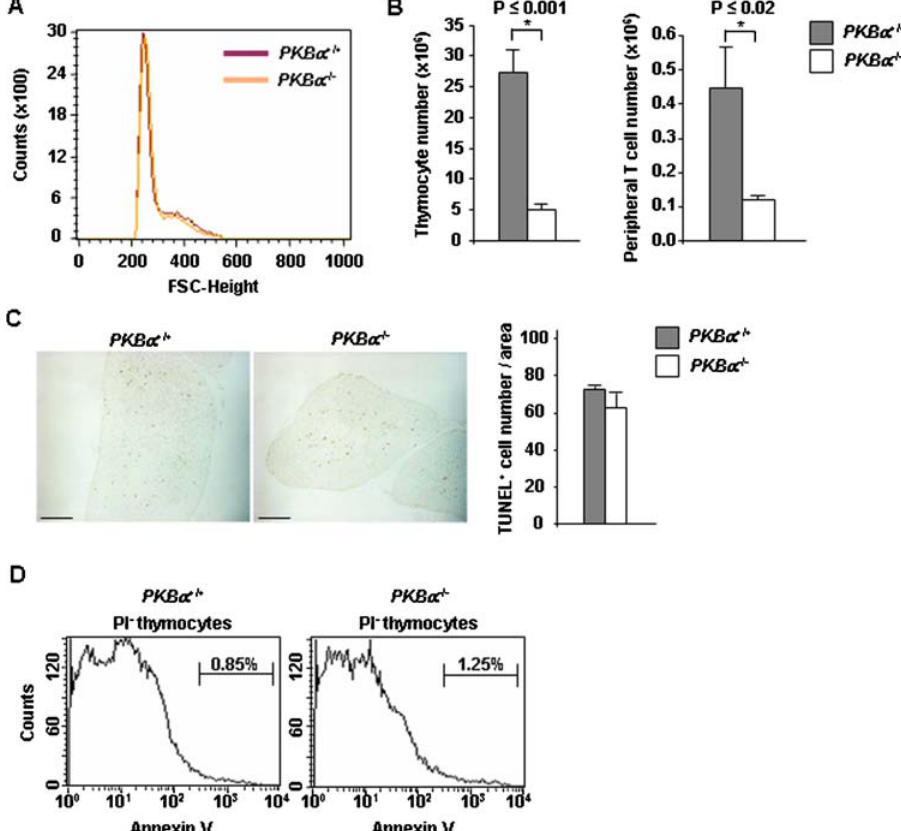
Figure 2. The deletion of PKB a leads to a reduced number of thymocytes in neonatal mice. A: Thymocytes were isolated from neonatal PKB a + / + and PKB a 2 / 2 littermates and their size compared by flow cytometry using the forward scatter (FSC) parameter. The histogram is representative of 3 litters. B: (left panel) Thymocytes were isolated and counted from PKB a + / + and PKB a 2 / 2 neonatal mice. (right panel) Lymphocytes isolated from the spleen of PKB a + / + and PKB a 2 / 2 neonates were stained with anti-CD19 and anti-CD3 antibodies. The number of T cells (CD3 + CD19 2 ) is shown. n $ 3. Error bars represent standard error of the mean. C: TUNEL assay on neonatal thymus sections from PKB a + / + and PKB a 2 / 2 littermates. The graph represents the quantification of TUNEL-positive cells from 5 fields on 3 sections. The result shown is representative of 3 independent experiments. The bar shown on the pictures represents 200 m m. Error bars represent standard error of the mean. D: Thymocytes were isolated from PKB a + / + and PKB a 2 / 2 neonates and stained with annexin V and propidium iodide (PI). Histograms show results that are representative of 2 independent experiments; n $ 3 (n=number of mice per genotype within the same experiment).